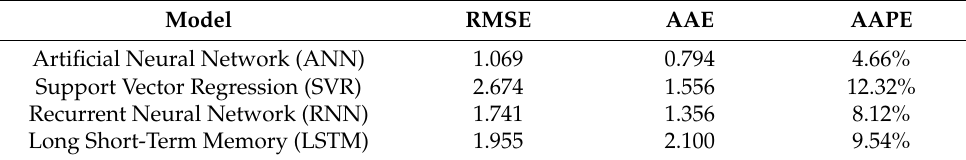
Table 4. Comparison of predicted accuracy for different artificial intelligence models. Model